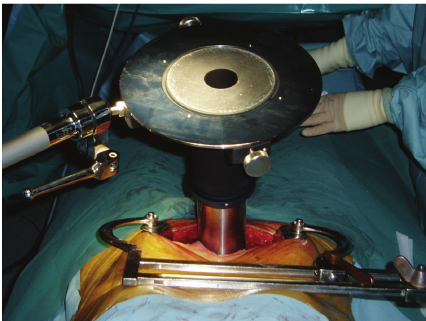
Figure 2: The collimator is fixed to the operating table.